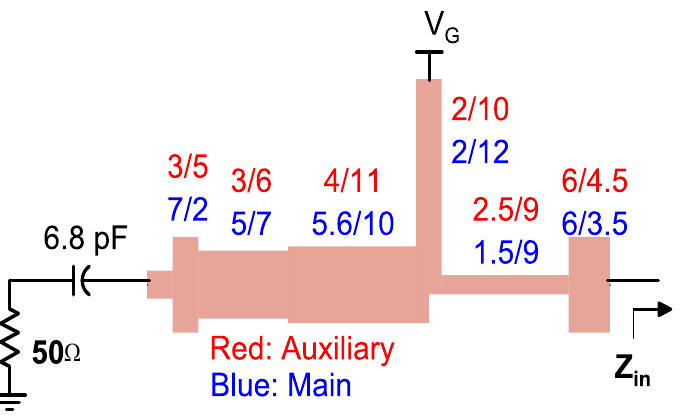
Figure 7. Layout of the input matching network (dimension: width/length (mm)).